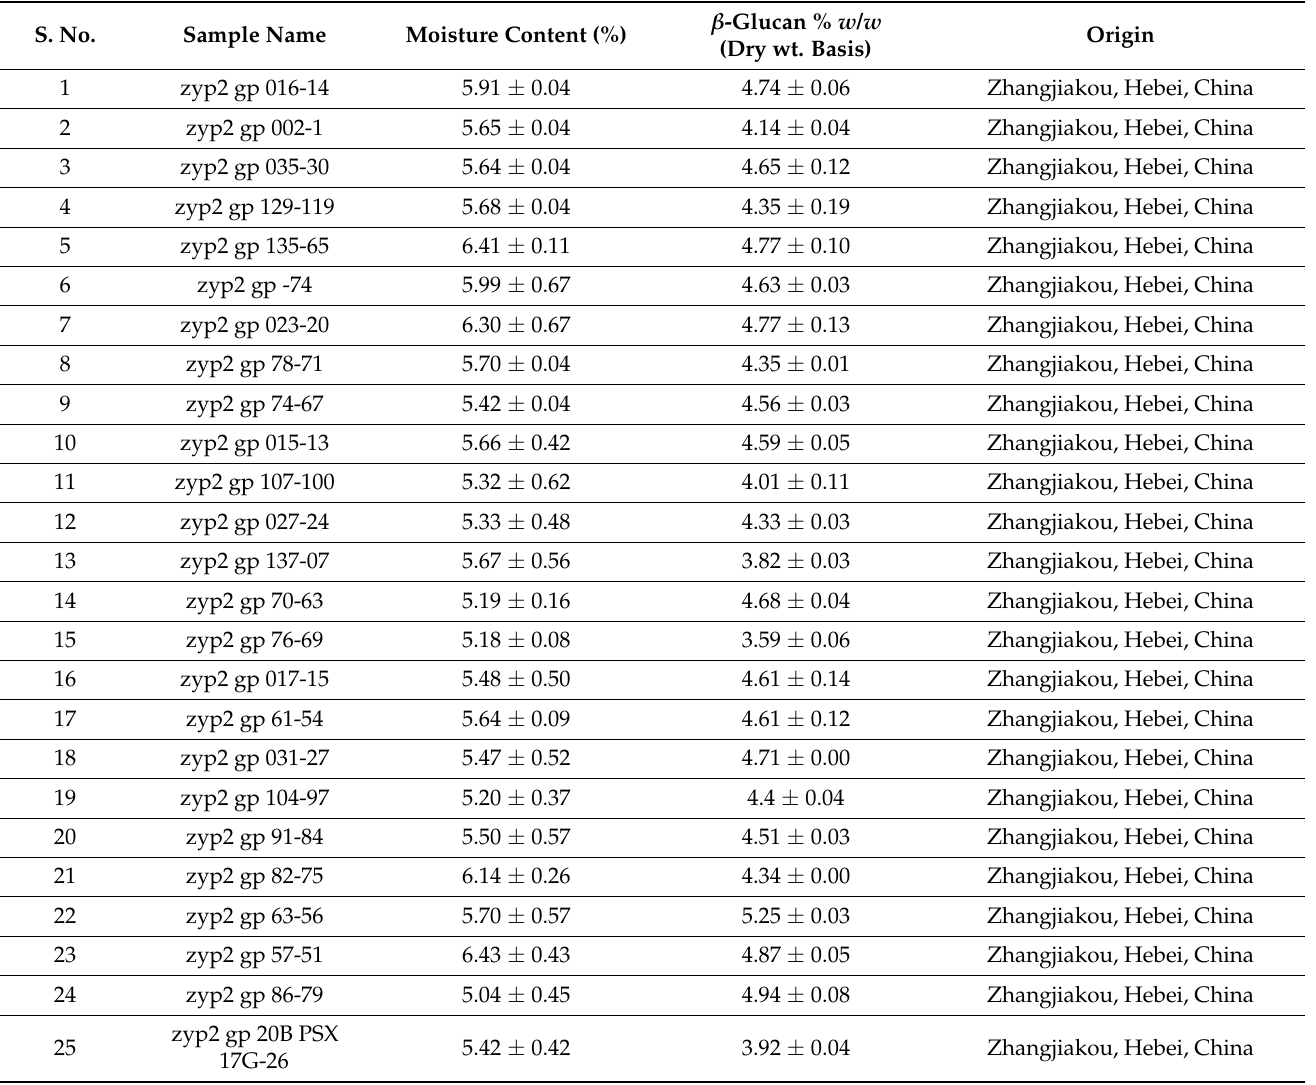
Table 1. β -glucan content, moisture content, and origin of hulled oat samples. S.